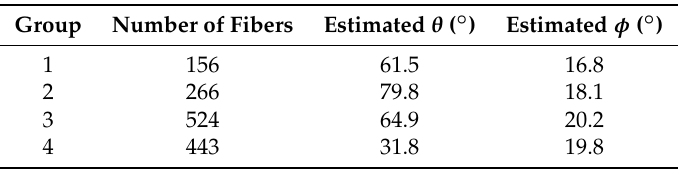
Figure 15. Fit ellipses colored by determined θ ( ◦ ) for micrograph of Figure 14. Table 6. Estimated angles from Figure